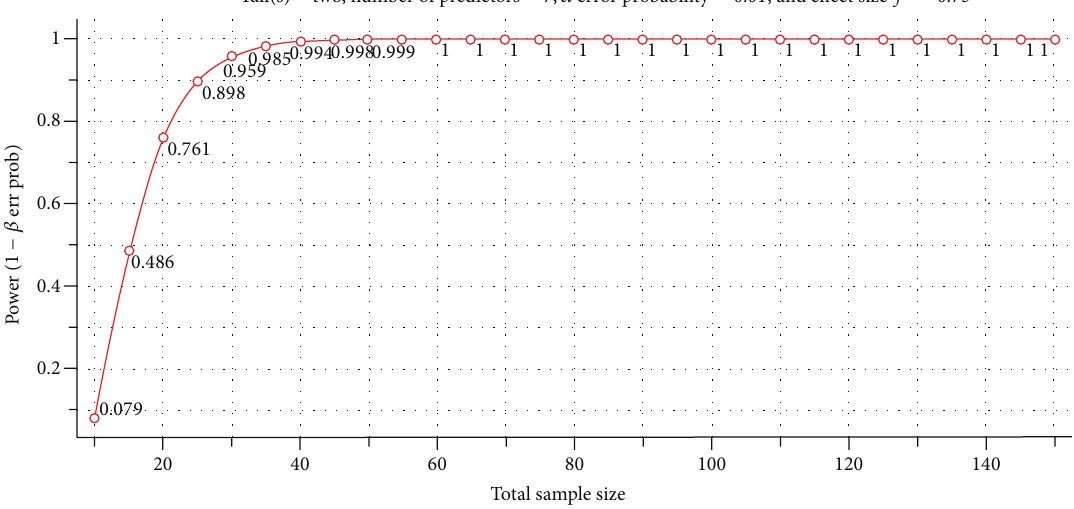
Figure 3: Generated power